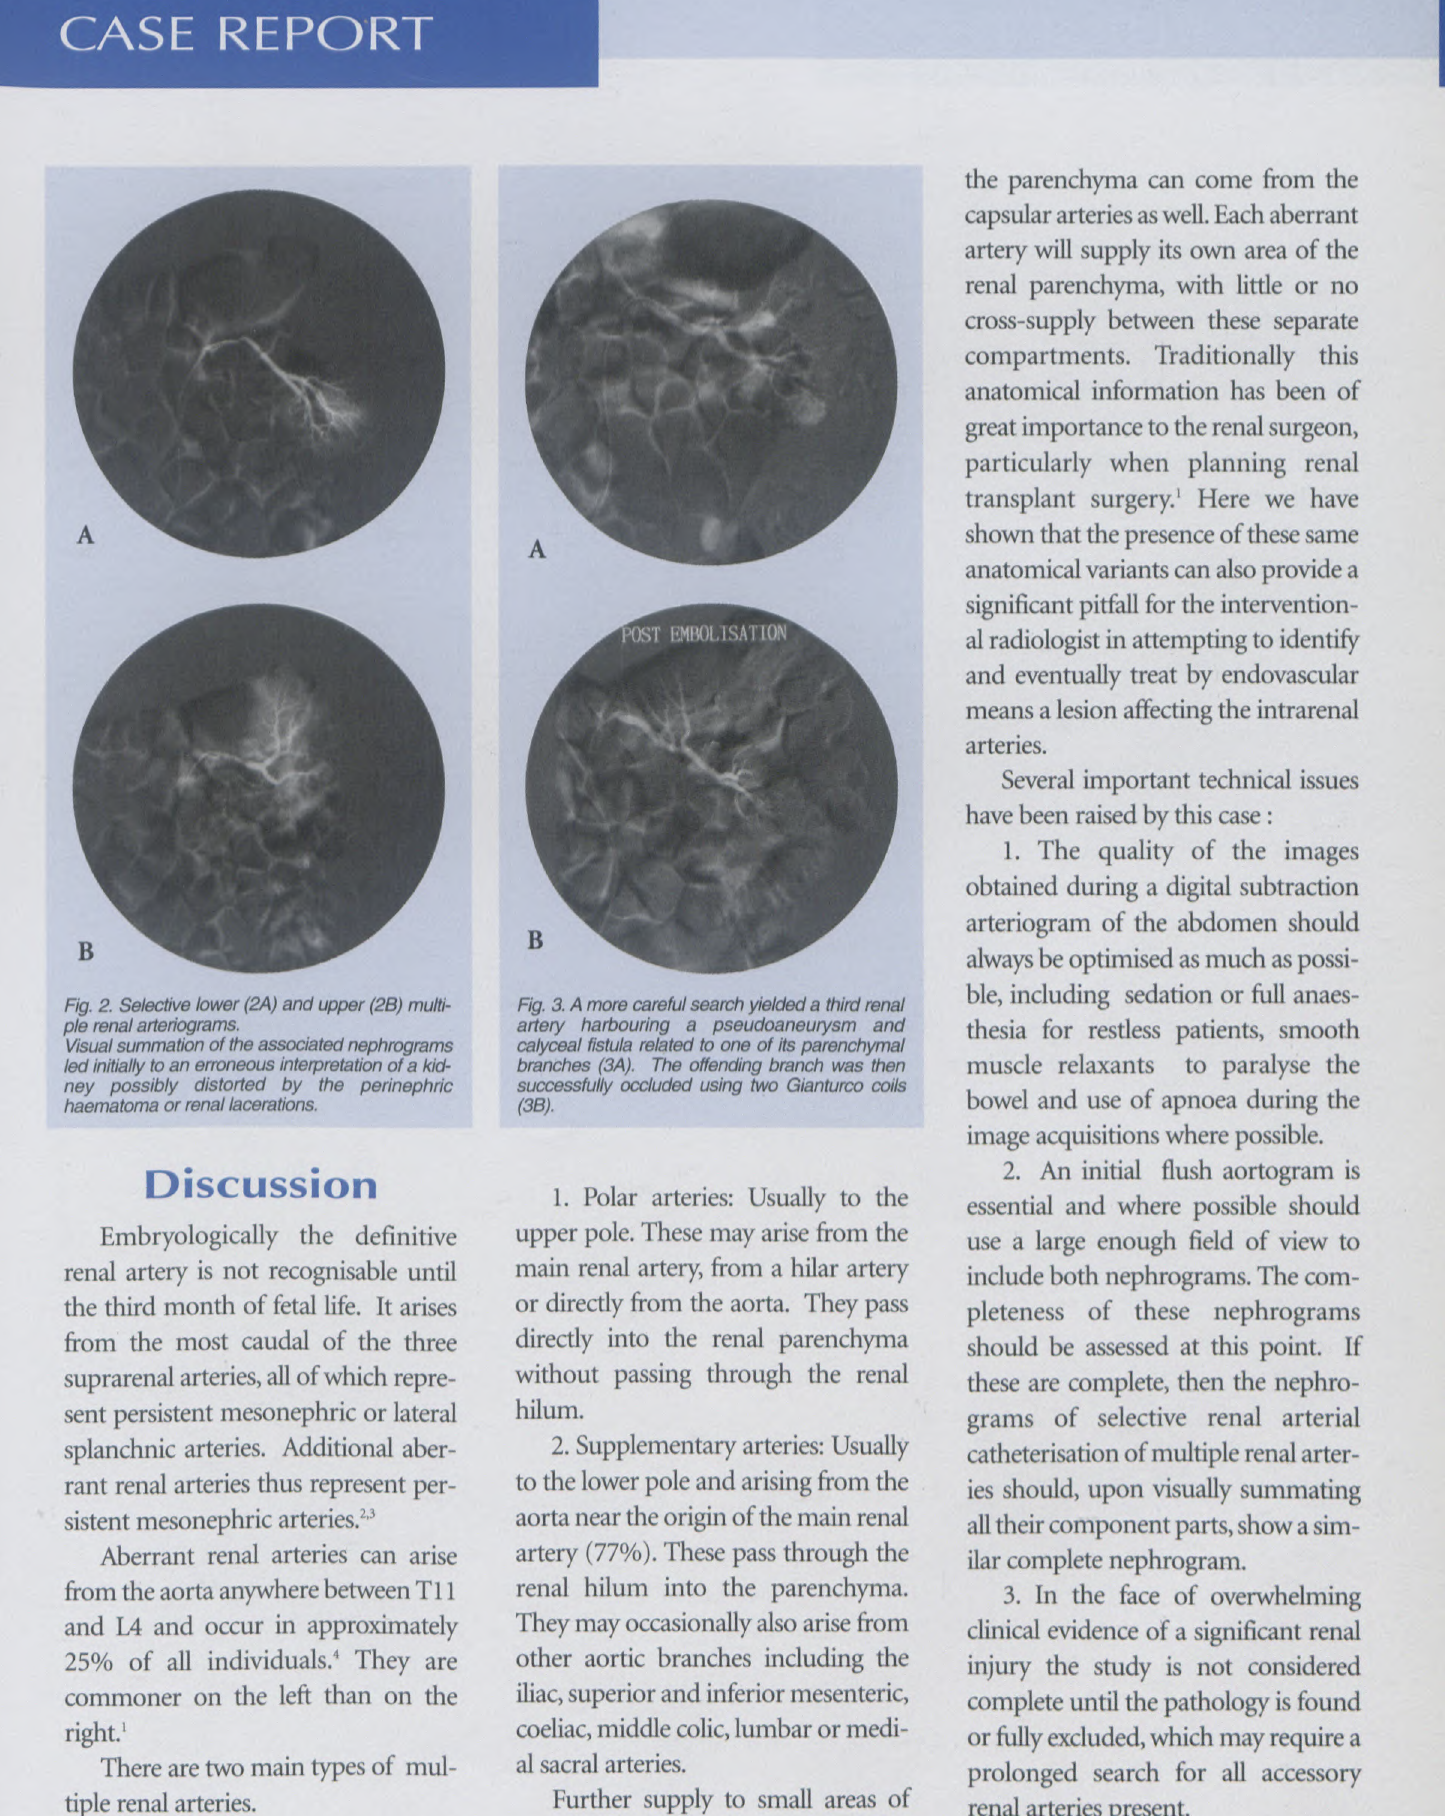
Fig. 2. Selective lower (2A) and upper (28) muiti- pie renal arteriograms. Visual summation of the associated nephrograms led initially to an erroneous interpretation of a kid- ney possibly distorted by the perinephric haematoma or renal lacerations.